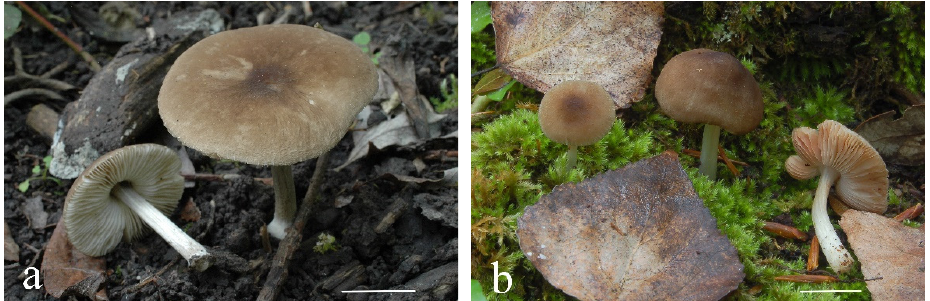
Figure 4. Pluteus pseudoinsidiosus basidiomata in situ: ( a ) holotype LIP0401350; ( b ) P. pseudoinsidiosus basidiomata in situ, GM3569.